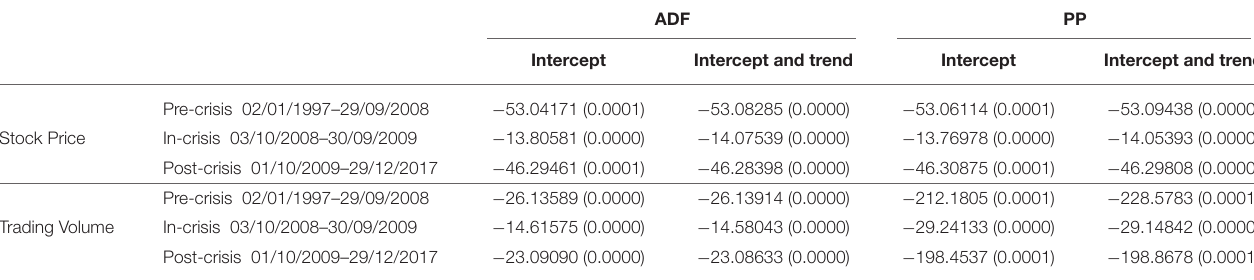
TABLE 1 | Result for Unit root tests.